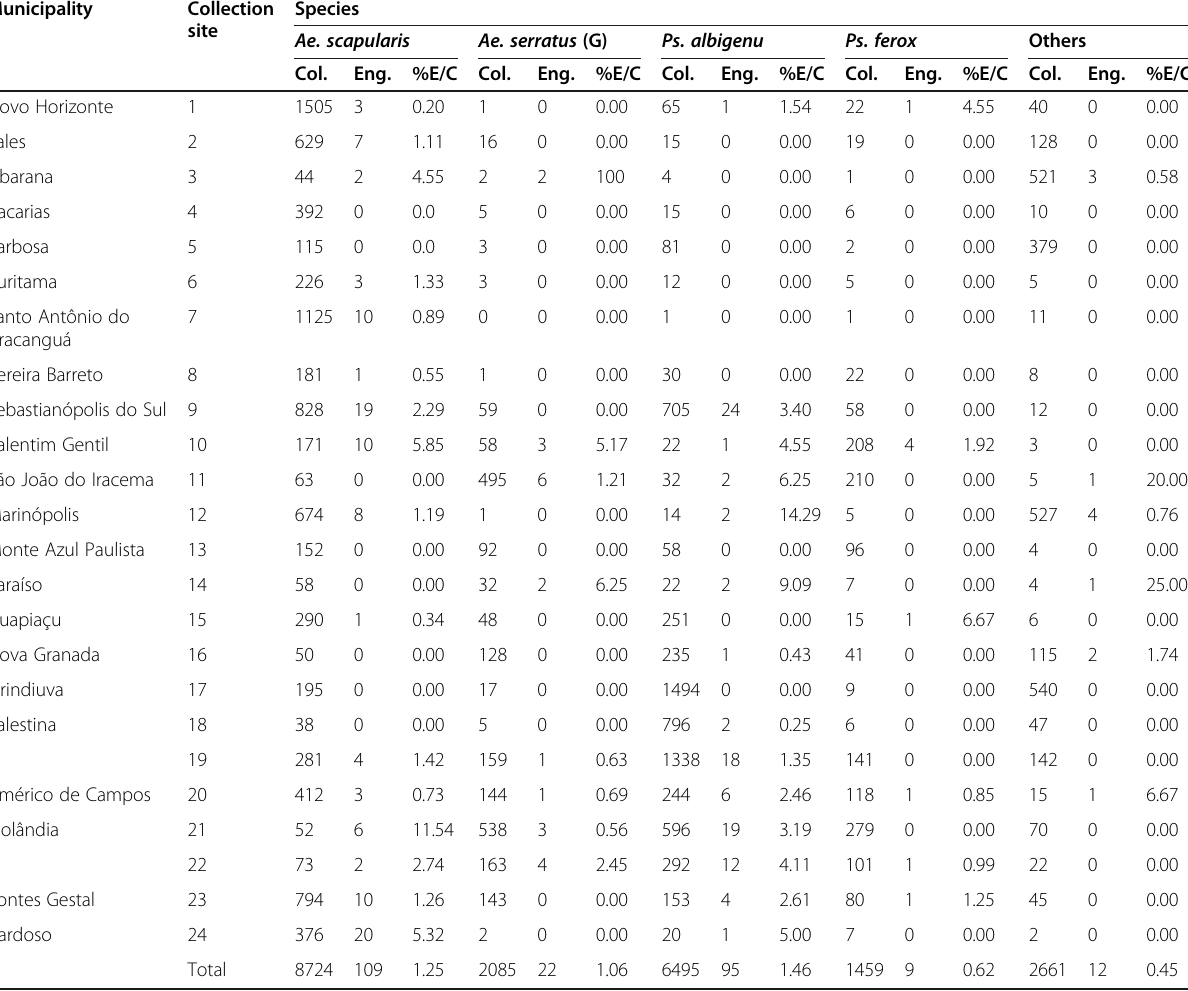
Table 1 Number of collected and engorged females by collection site and municipality